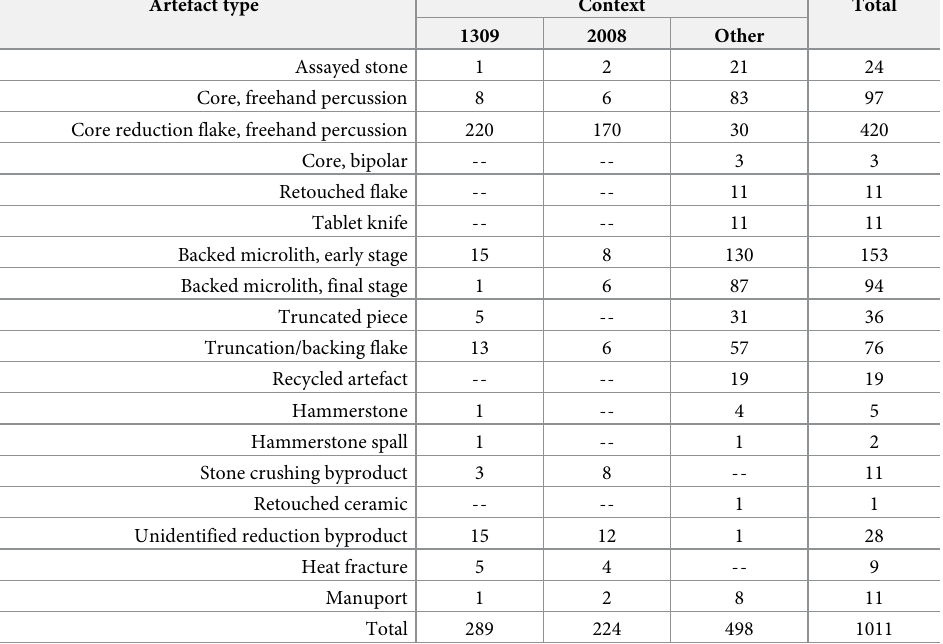
Table 1. Counts of stone artefact types, Horizon IV, Saruq al-Hadid. Artefact